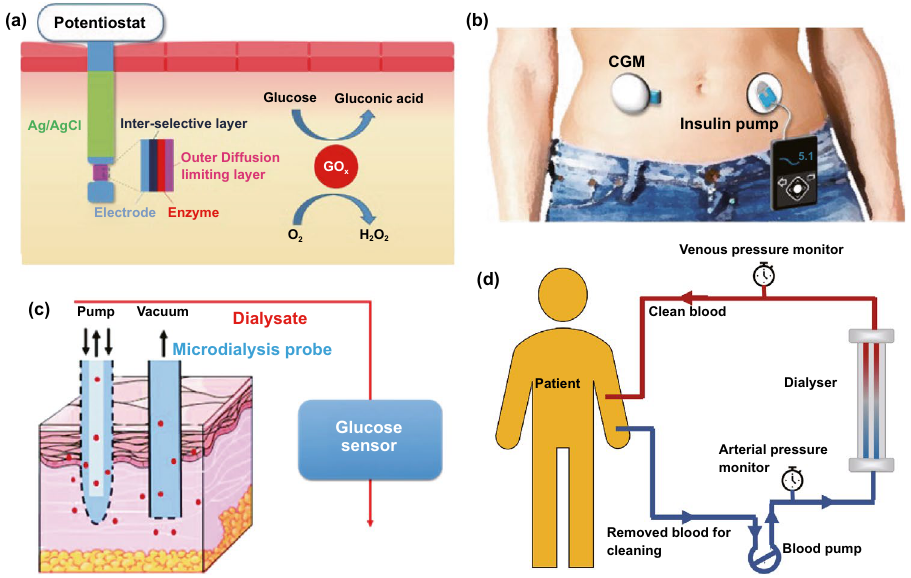
Fig. 8 Representative transdermal semi‑implantable device. a Configuration and principle of percutaneous electrochemical glucose biosensor. b CGM‑based close‑loop insulin pump system. c Microdialysis probes for glucose monitoring [152]. d Hemodialysis system. Reproduced with permission from Ref. [152], copyright (2015) The Royal Society of Chemistry Publishing